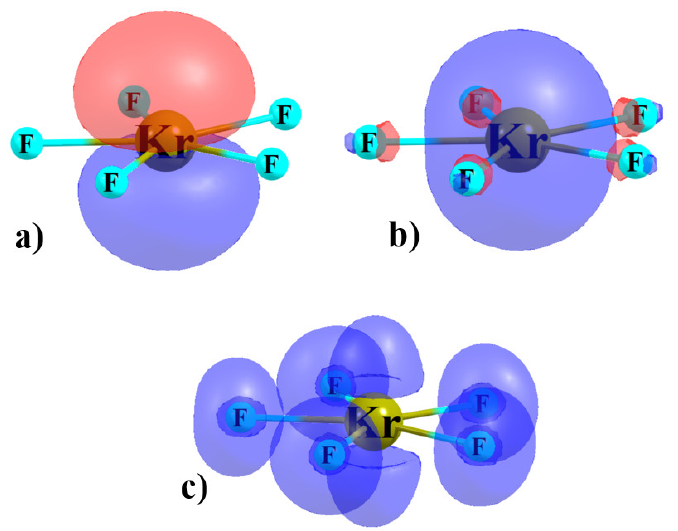
Figure 3. Doubly occupied NBO ( a ) p and ( b ) s -orbitals of KrF 5- monomer, and ( c ) ELF